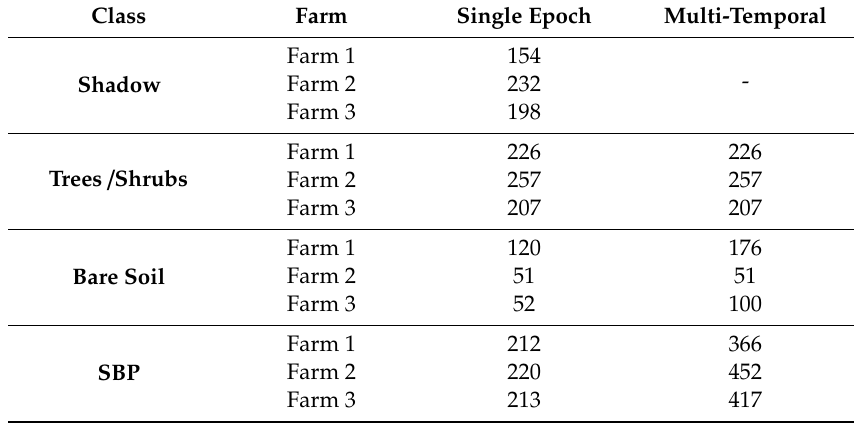
Table A1. Number of polygons used for training for each class in single epoch and multitemporal classification. SBP—Sown Biodiverse